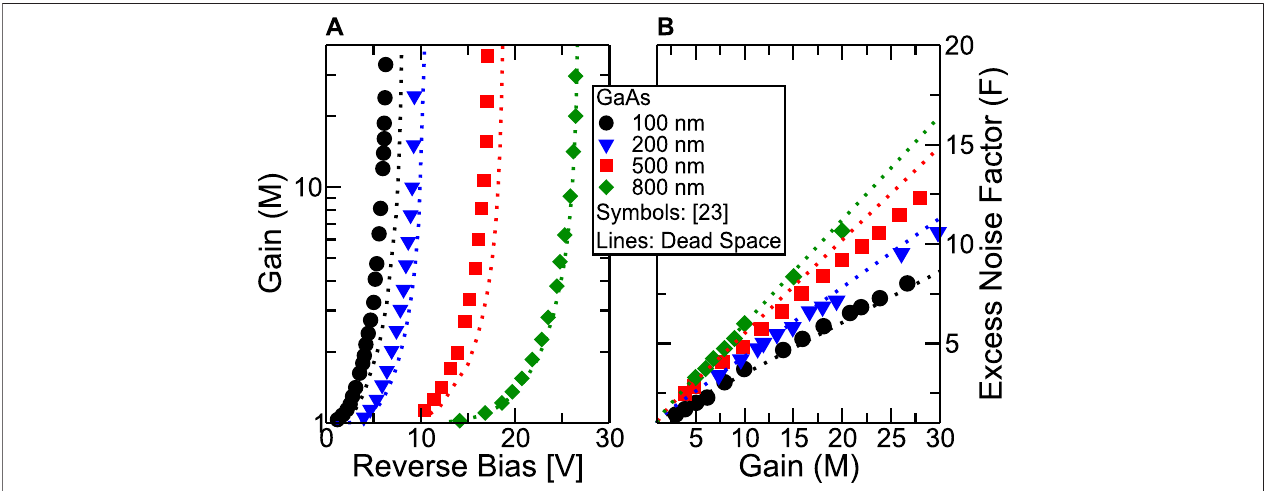
FIGURE6| Comparison between thedead-space modeland the experiments in [23] forGaAsp-i-ndiodes withdifferent width oftheintrinsic region. Plot (A) : gain vs. applied voltage. Plot (B) : excess noise factor vs. gain.